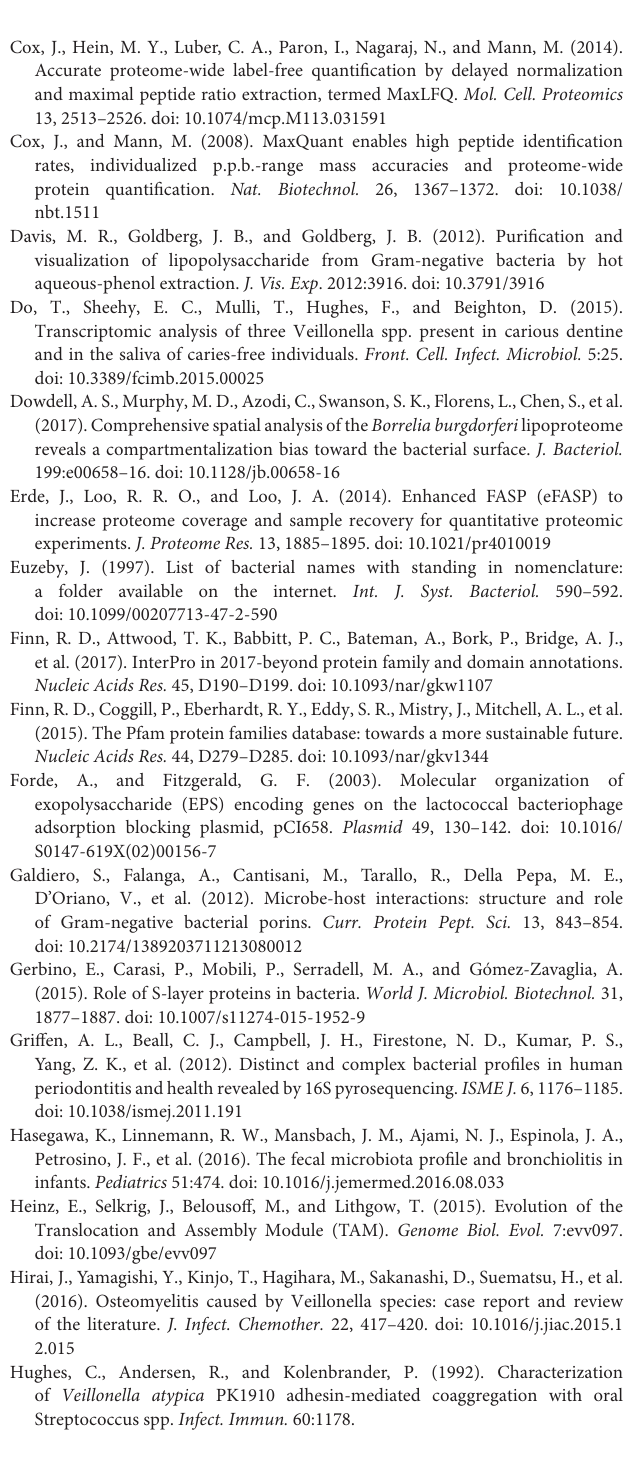
highlighted. Table S6 | IBAQ results for the OM